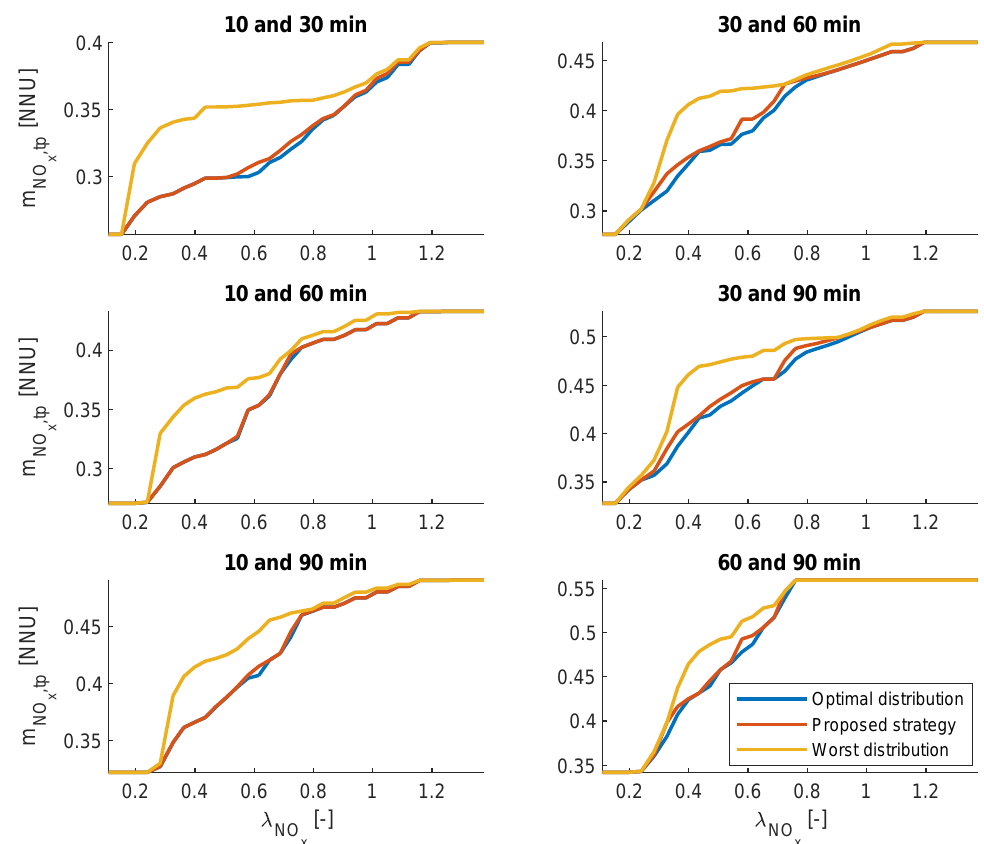
Figure 11. Redistribution of fuel between engine-off times 10 and 60 min and λ NO The blue circle marks the optimal distribution (minimum NO x ) and the red the distribution from the proposed strategy.